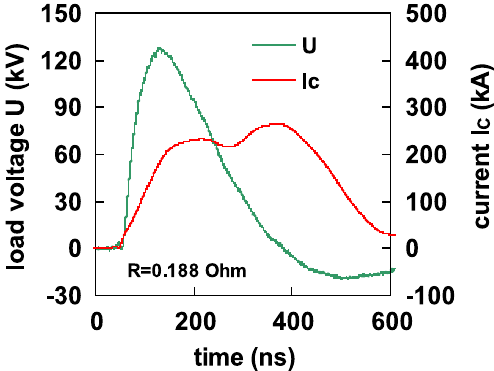
FIG. 8. (Color) Same traces as in Fig. 7 but with a different R ¼ 0 : 188 Ohm . Because of higher voltage U the volt-second inte- gral VS U exceeds the limit VS P C ¼ 18 mVs at (cid:1) 200 ns in the pulse. At that time the current I C begins to rise again, indicating saturation of the